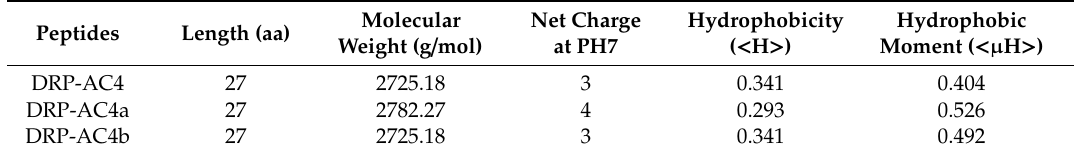
Table 1. Physiochemical properties of DRP-AC4, DRP-AC4a and DRP-AC4b predicted by the Heliquest online website.